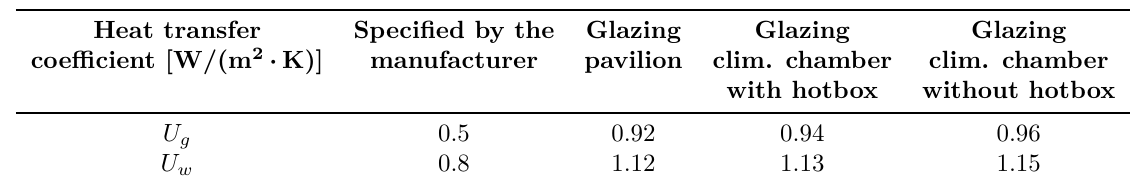
Table 3. Heat transfer coefficient window U